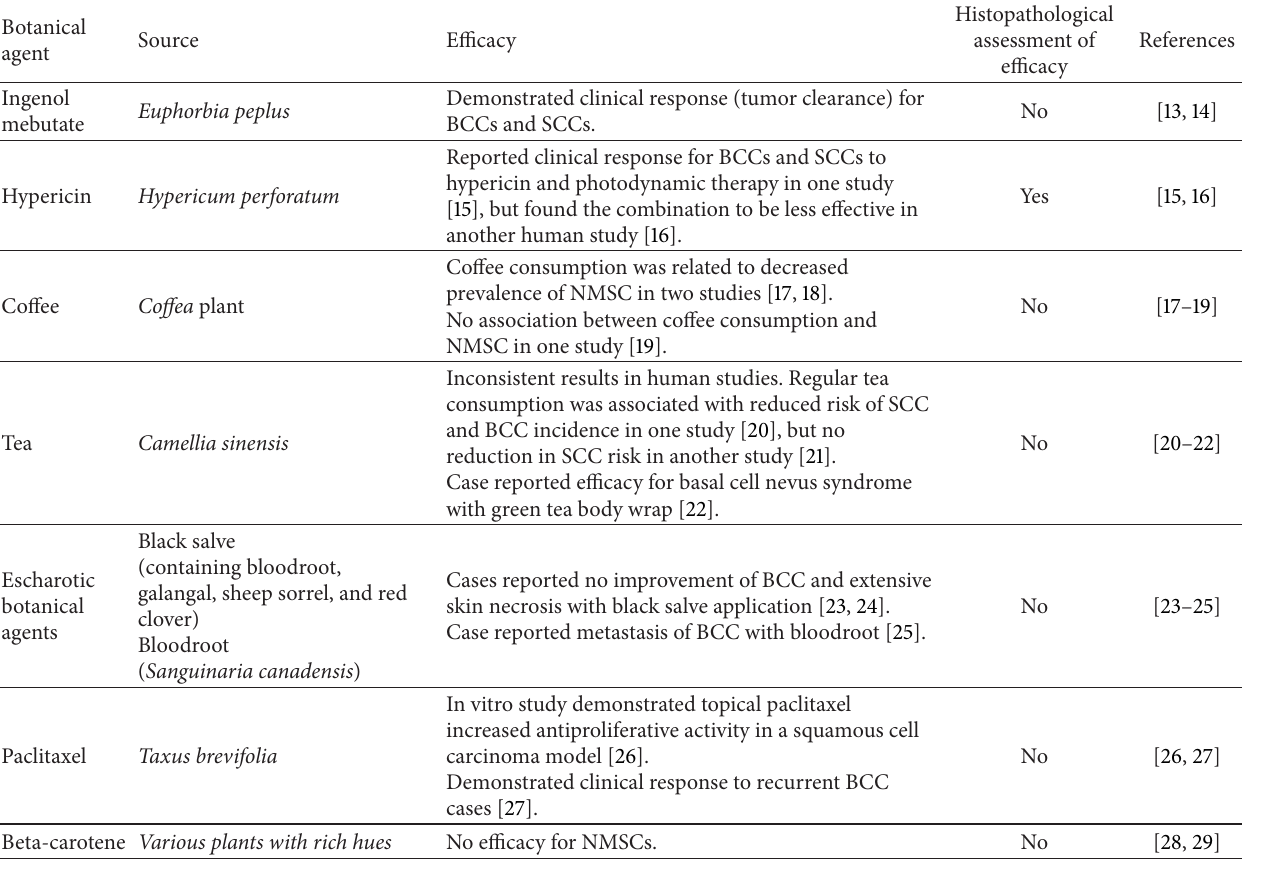
Table 1: Summary of the effects of botanical agents studied in humans.